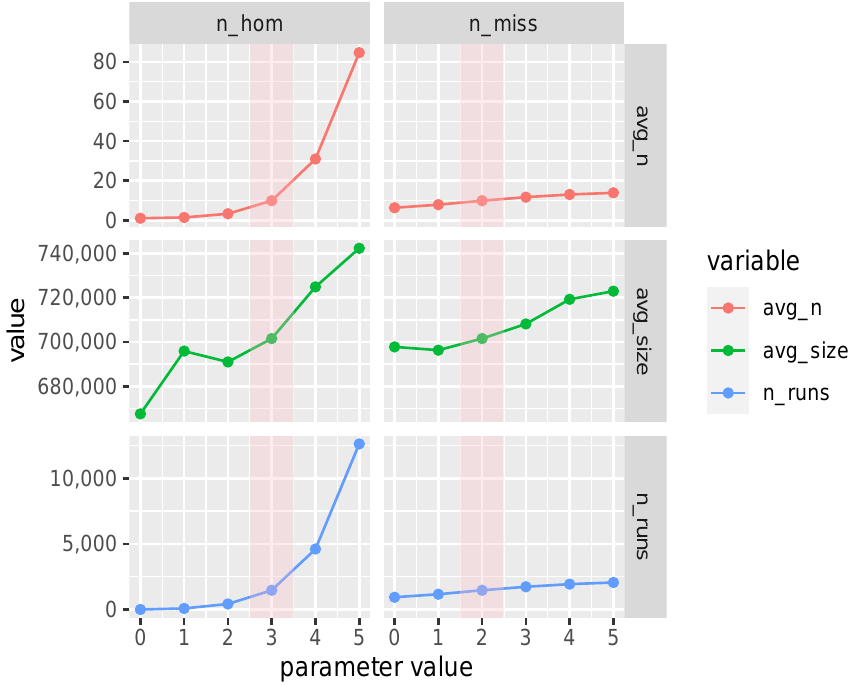
Figure 8. Number of ROHet (n_runs), average ROHet size (avg_size) and average number of ROHet per animal (avg_n) per different values of parameters used to detect ROHet in the Maremmana cattle genome: number of homozygous genotypes allowed in a ROHet (n_hom), number of missing genotypes allowed in a ROHet (n_miss). The areas shaded in pink highlight the base scenario (n_hom = 3, n_miss =